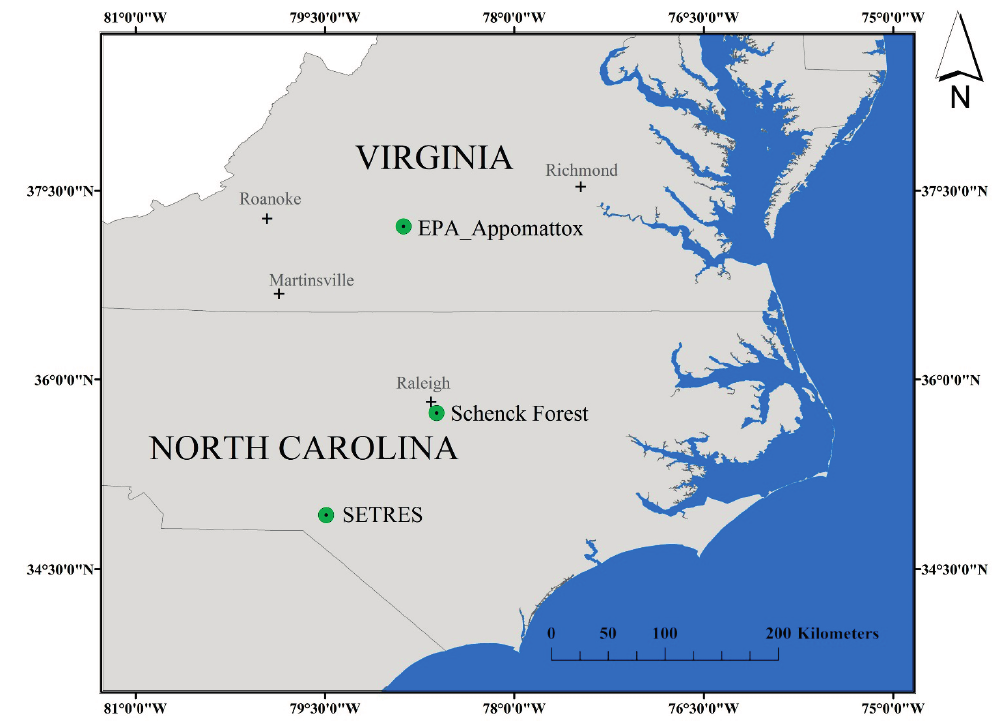
Figure 1. LAI study site locations include the 1-km 2 validation site (EPA_Appomattox)